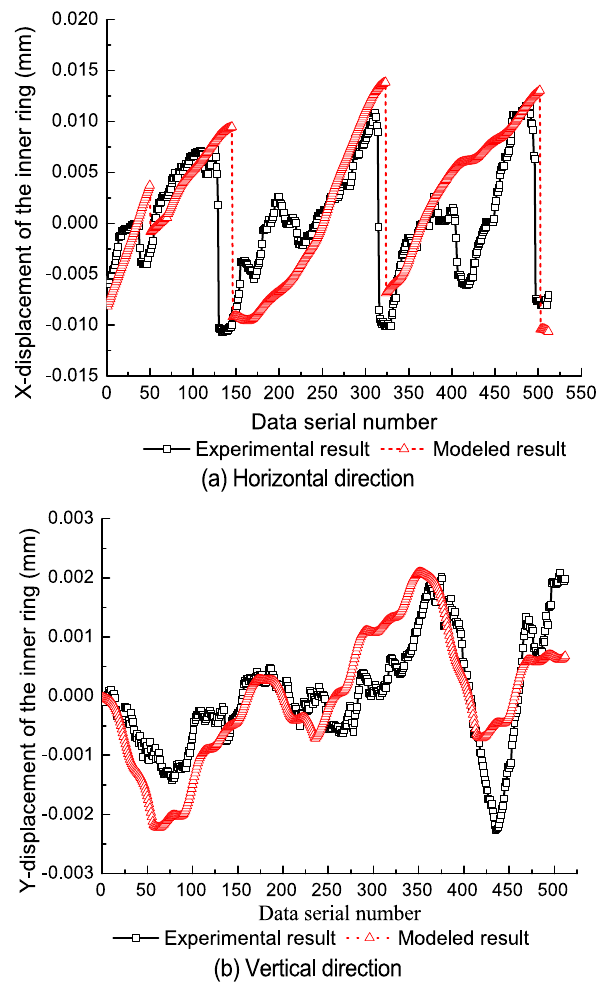
Figure 7. Third test bearing comparison between the experimental results and modeled